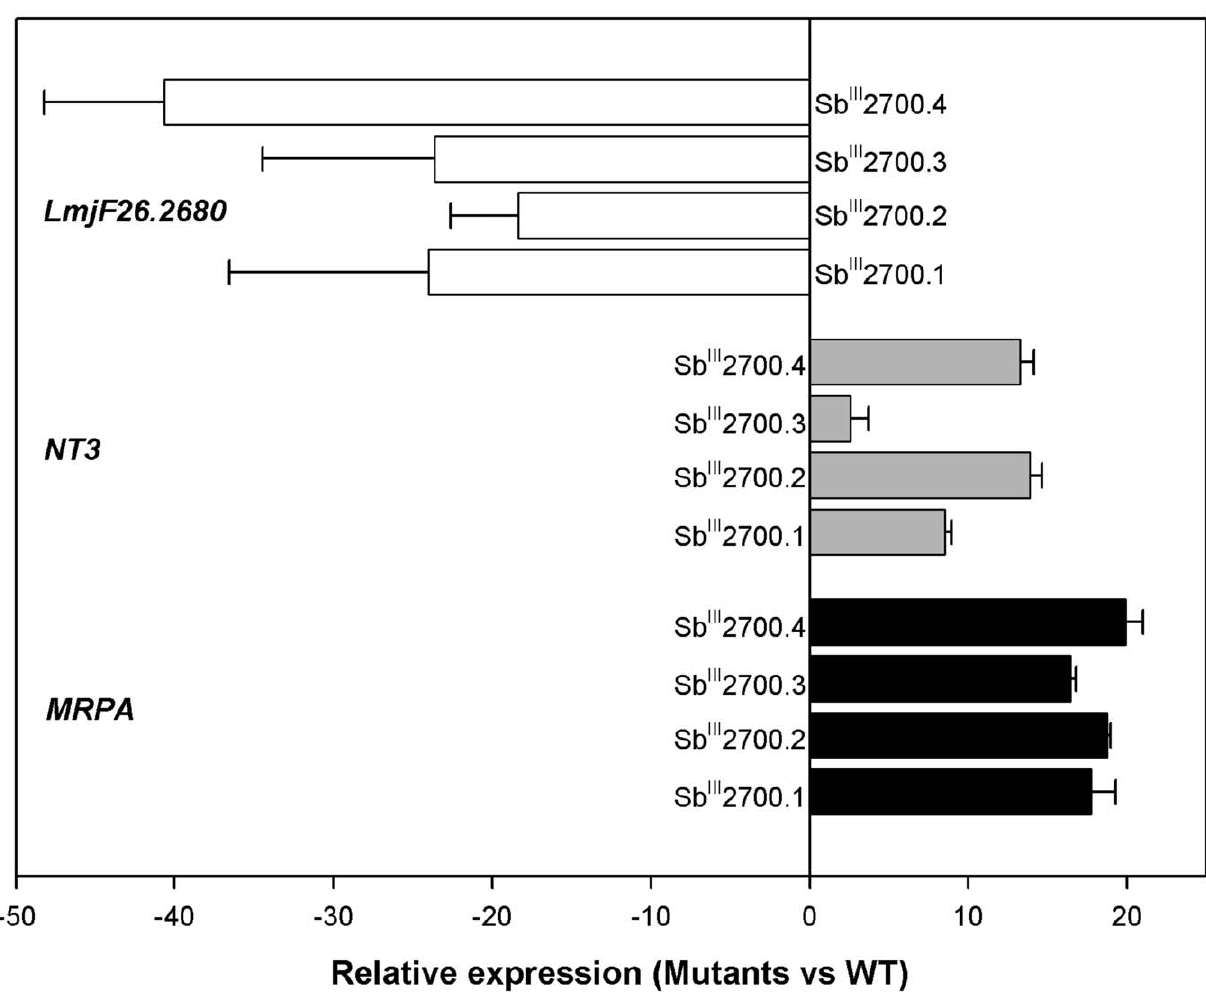
Figure 4. RNA expression in L.amazonensis antimony resistant mutants by quantitative real time RT-PCR. The RNA expression ratios of the nucleobase transporter gene NT3 , the ABC protein MRPA gene and the hypothetical protein encoding gene LmjF26.2680 were measured in L. amazonensis antimony resistant mutants, which were compared to levels found in WT cells. The expression of GAPDH was used to normalize the data. The values are the mean of two independent experiments each performed with three biological RNA